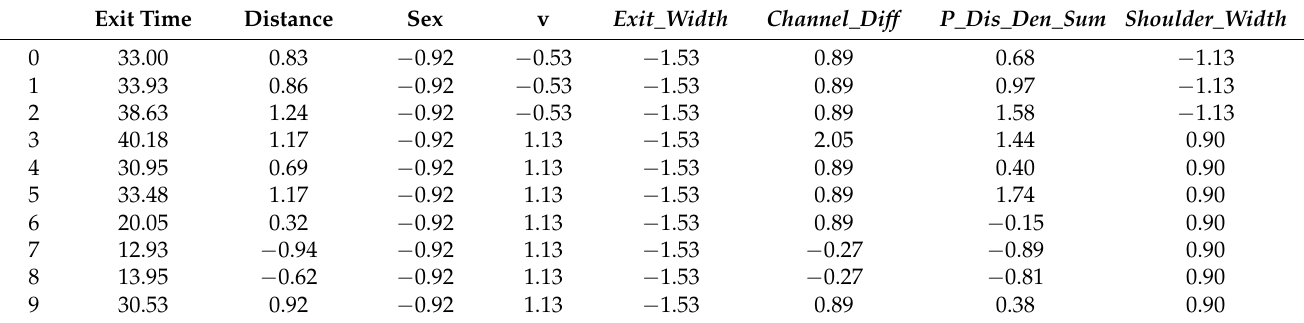
Table 5. Partial normalized